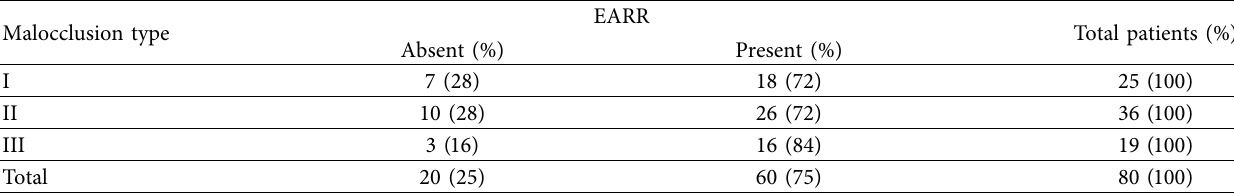
Table 2: Frequency of EARR in maxillary anterior teeth of patients based on the type of malocclusion (number of patients is reported). Malocclusion type